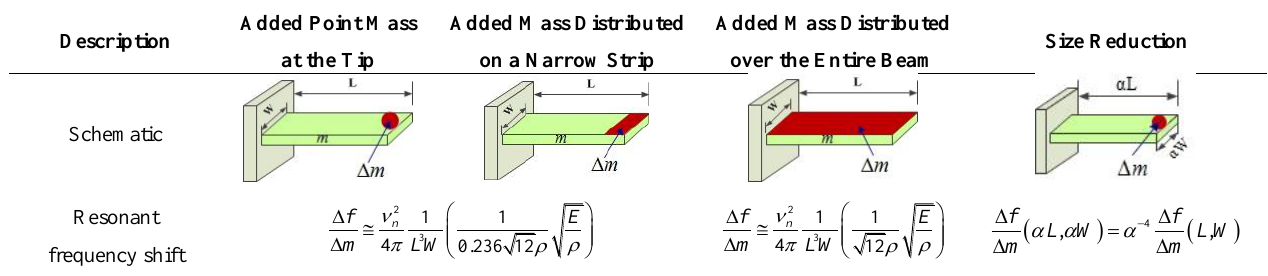
Figure 4. ( a ) SEM of a clamped-free beam resonator with added mass at the tip. Reused with permission from [87]; ( b ) Schematic of the undamped spring-mass system with added mass effect. Table 1. Effect of added mass on the resonant frequency shift of the cantilever beam reported by Yi et al . [91]. Reused with permission from